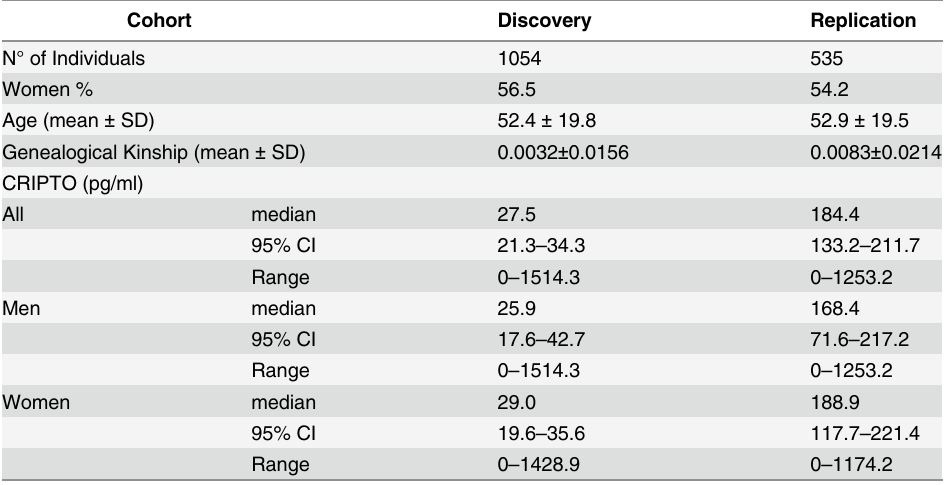
Table 1. Characteristics of the study